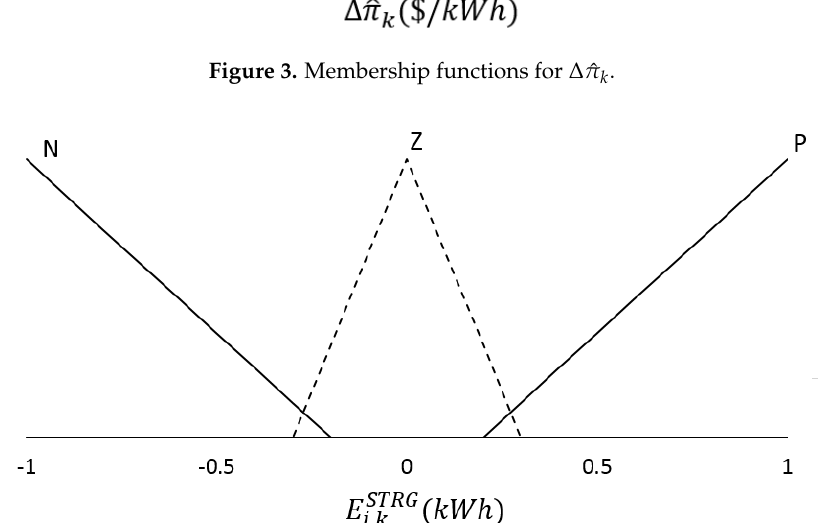
Figure 4. Membership functions for E STRG